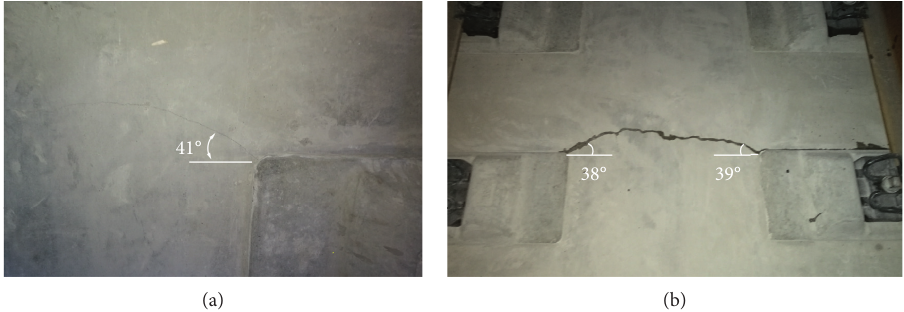
Figure 3: Distribution of cracks on the surface of track slab. (a) Initial crack. (b) Crack